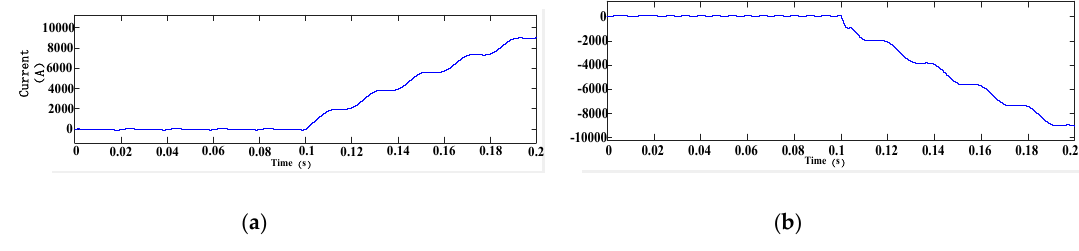
Energies 2019 , 12 , x FOR PEER REVIEW Figure 12. Arm current without fault blocking: ( a ) 𝑖 (cid:3022)(cid:3028) and ( b ) 𝑖 (cid:3013)(cid:3029) . Figure 12. Arm current without fault blocking: ( a ) i Ua and ( b ) i Lb .